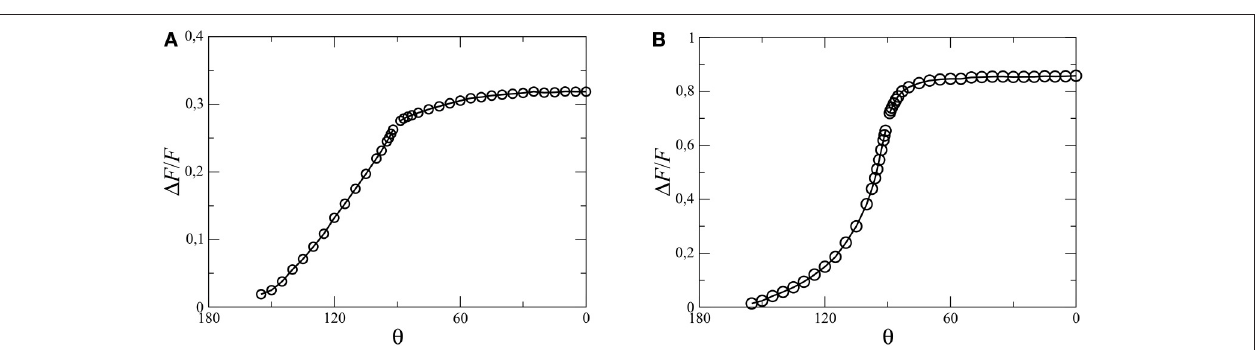
FIGURE 6 | Proportionate change in the steady-state oil fractional-flow ( 1 F / F ) due to wettability alteration as a function of maximum wetting angle θ . For (A) the capillary number Ca = 10 − 1 with oil-saturation S = 0.3 and for (B) Ca = 10 − 2 with S = 0.4 .